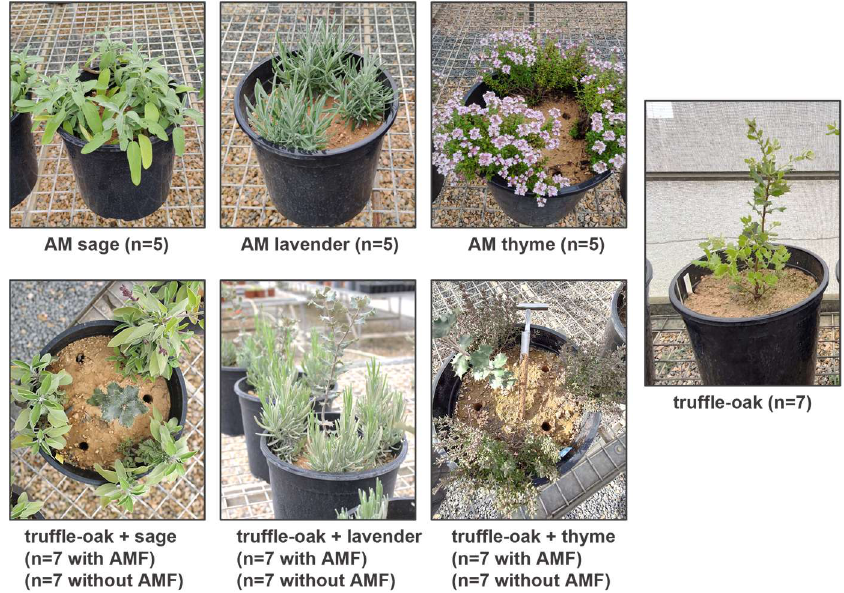
Figure 1. Experimental set-up of interactions between evergreen oak ectomycorrhizal with Tuber melanosporum (truffle-oak) and three species of medicinal and aromatic plants (MAPs), inoculated with arbuscular mycorrhizal fungi (AMF) or non-inoculated. Truffle-oak and MAPs growing alone were used as controls.